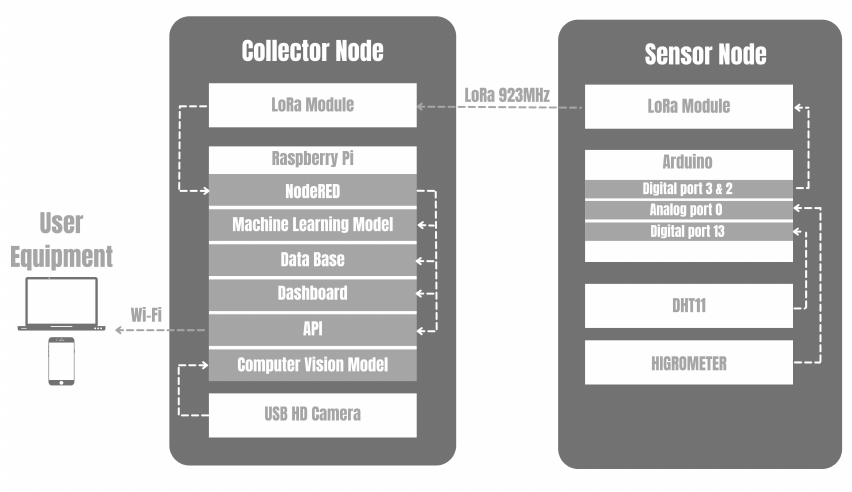
Figure 6. Software architecture.